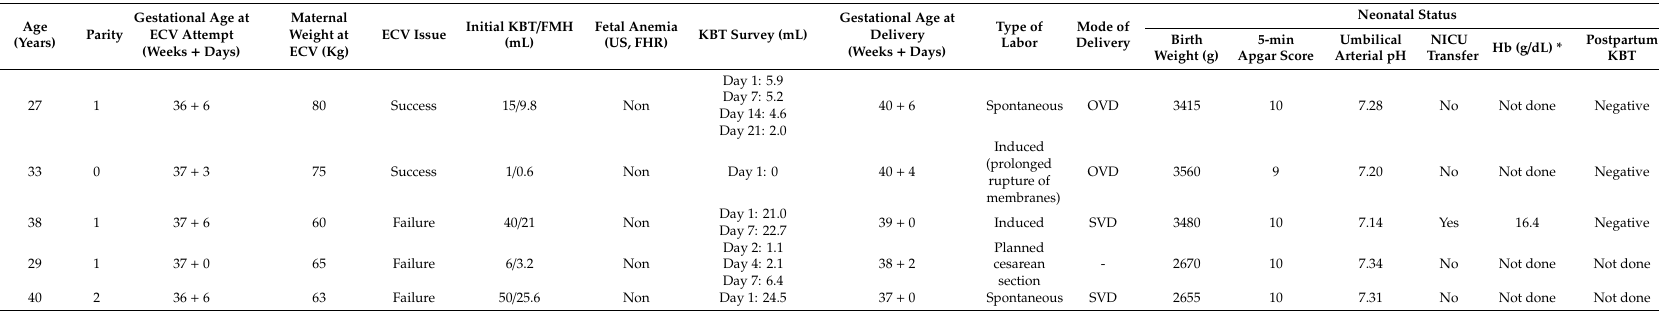
Table 2. Maternal characteristics and neonatal outcome in cases of positive Kleihauer–Betke test after external cephalic version for a breech presentation at term. GestationalAgeat Age ECVAttempt (Years) Parity (Weeks +